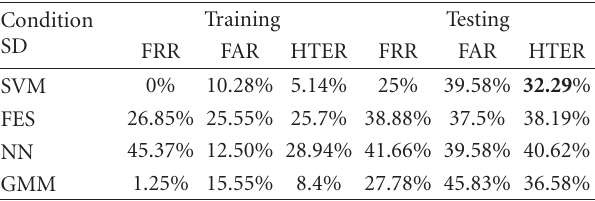
Table 4: Training and evaluation results for the detection of sleep deprivation (SD) using all available